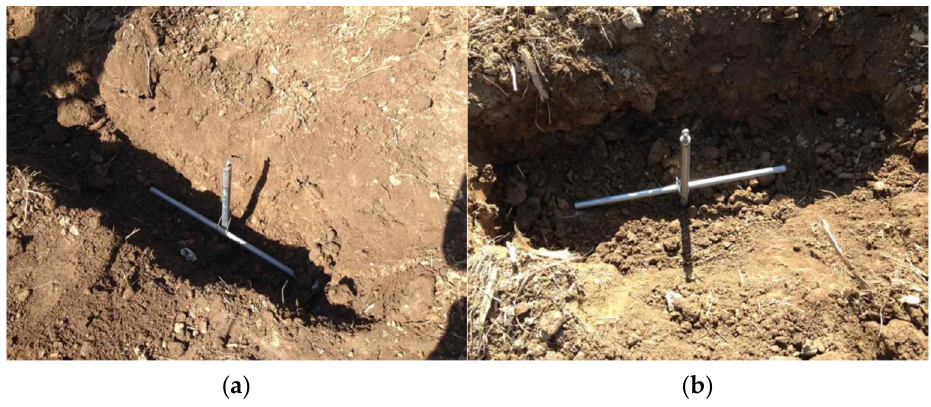
Figure 16. Continuous pipe foundation for field test. ( a ) Steel wire, ( b ) steel plate